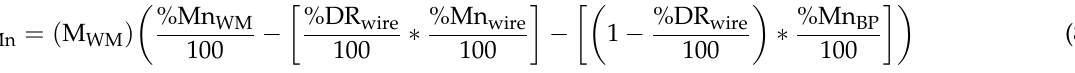
Table 3. The square bracketed terms in Equation (8) represent the calculation of the BC